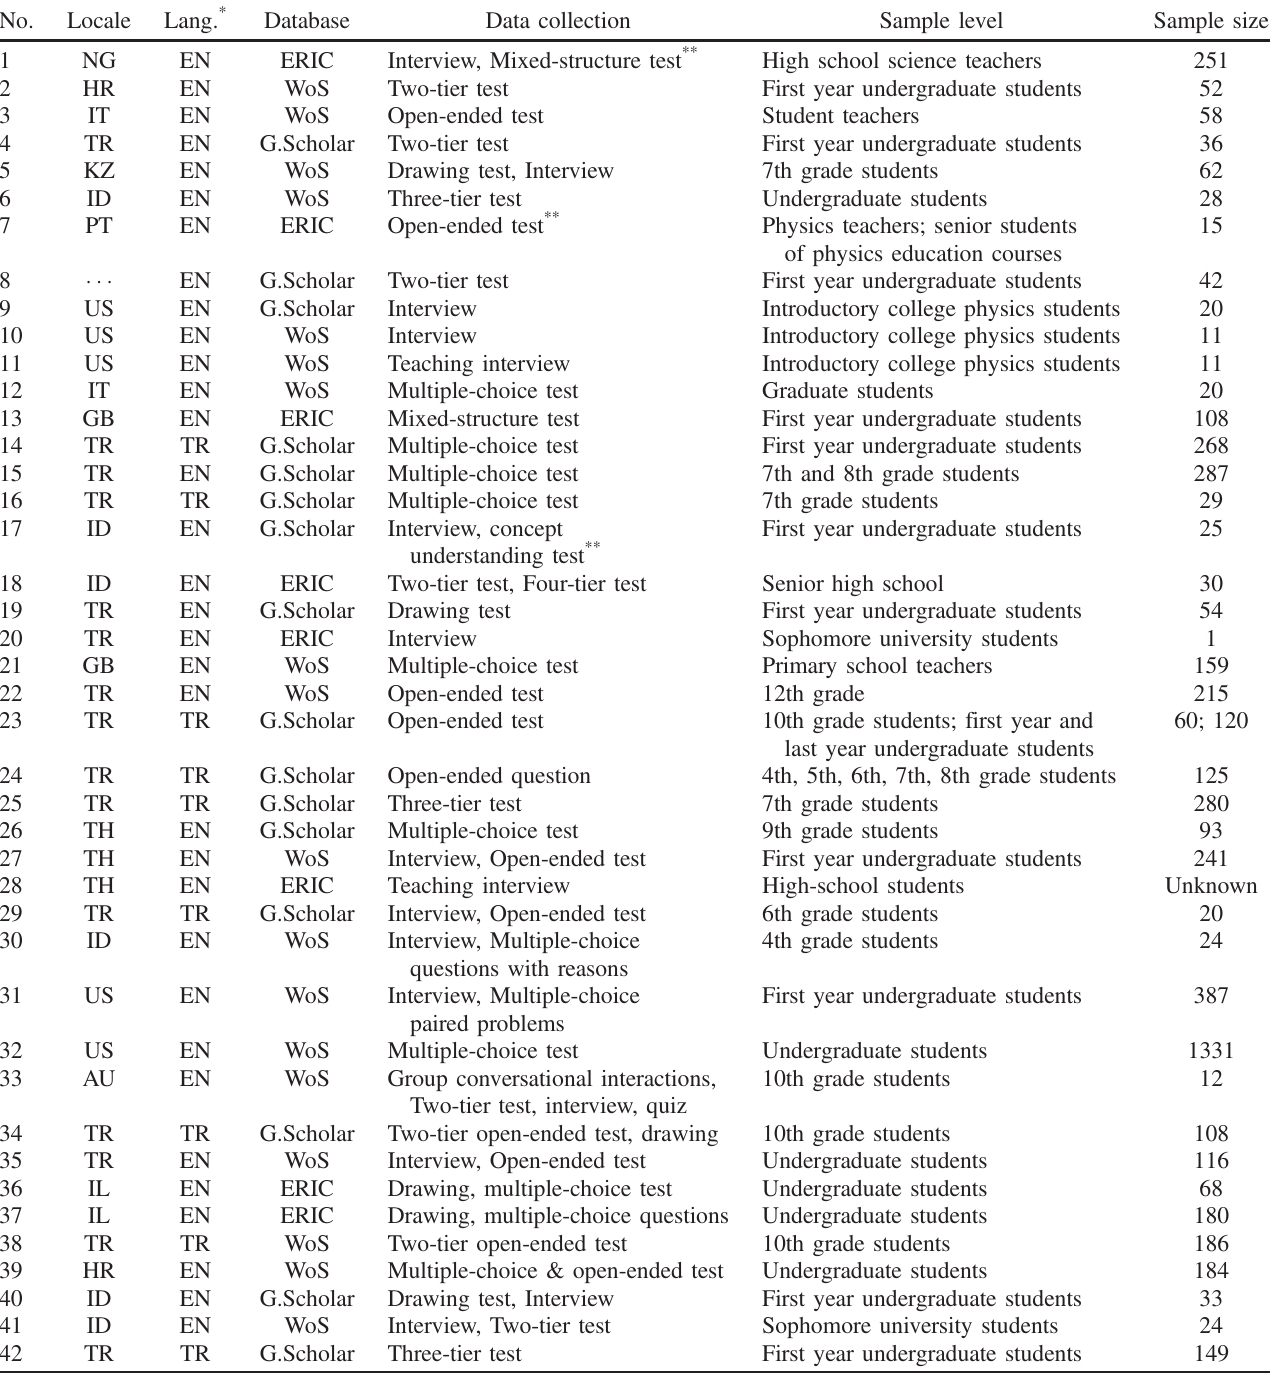
TABLE I. Bibliometrics of the